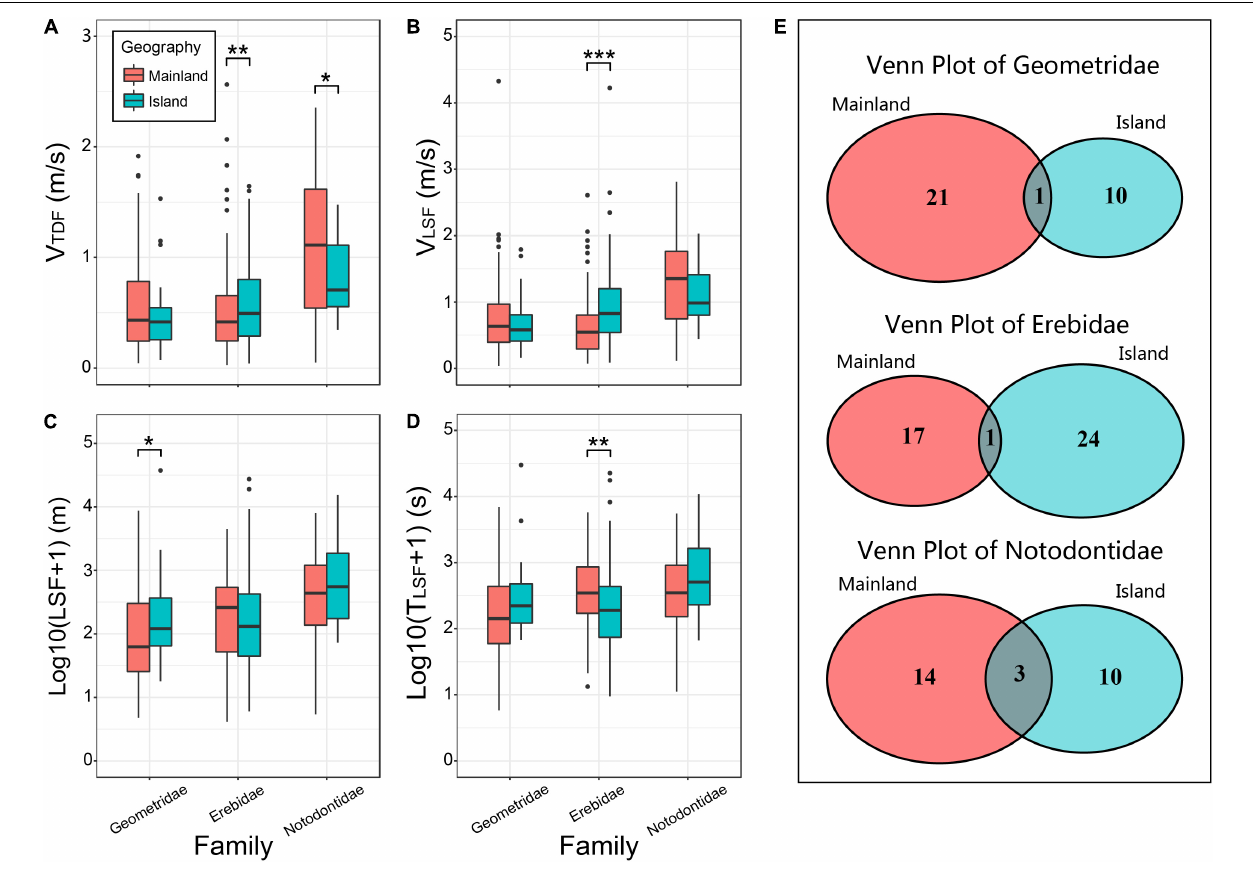
FIGURE 2 | Comparison of flight capabilities between mainland and island (Geometridae, Erebidae, and Notodontidae). (A–D) Box plot of comparing the flight capabilities of mainland and island samples. The difference between the samples is calculated by the Wilcoxon rank-sum test of the two-tailed hypothesis ( ∗ : 0 . 01 ≤ p < 0 . 05, ** : 0 . 001 ≤ p < 0 . 01, *** : p < 0 . 001),only the samples with significant differences between Mainland and Island are marked with *, ** or *** in this figure. (E) Venn diagram of species in three families captured from mainland and island.